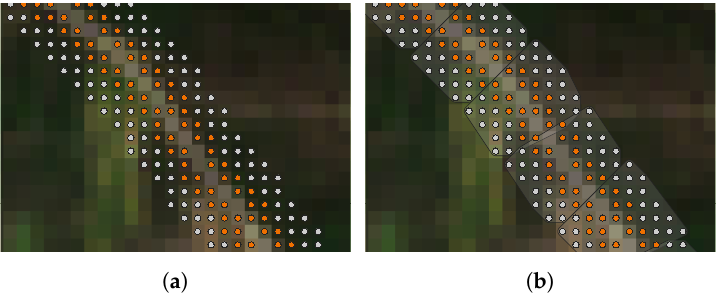
Figure 7. Stages of segment creation. ( a ) Points of the interior (orange) and the exterior buffer of the FMZ (gray). ( b ) Clusters generated using K-Means. K = 5200.